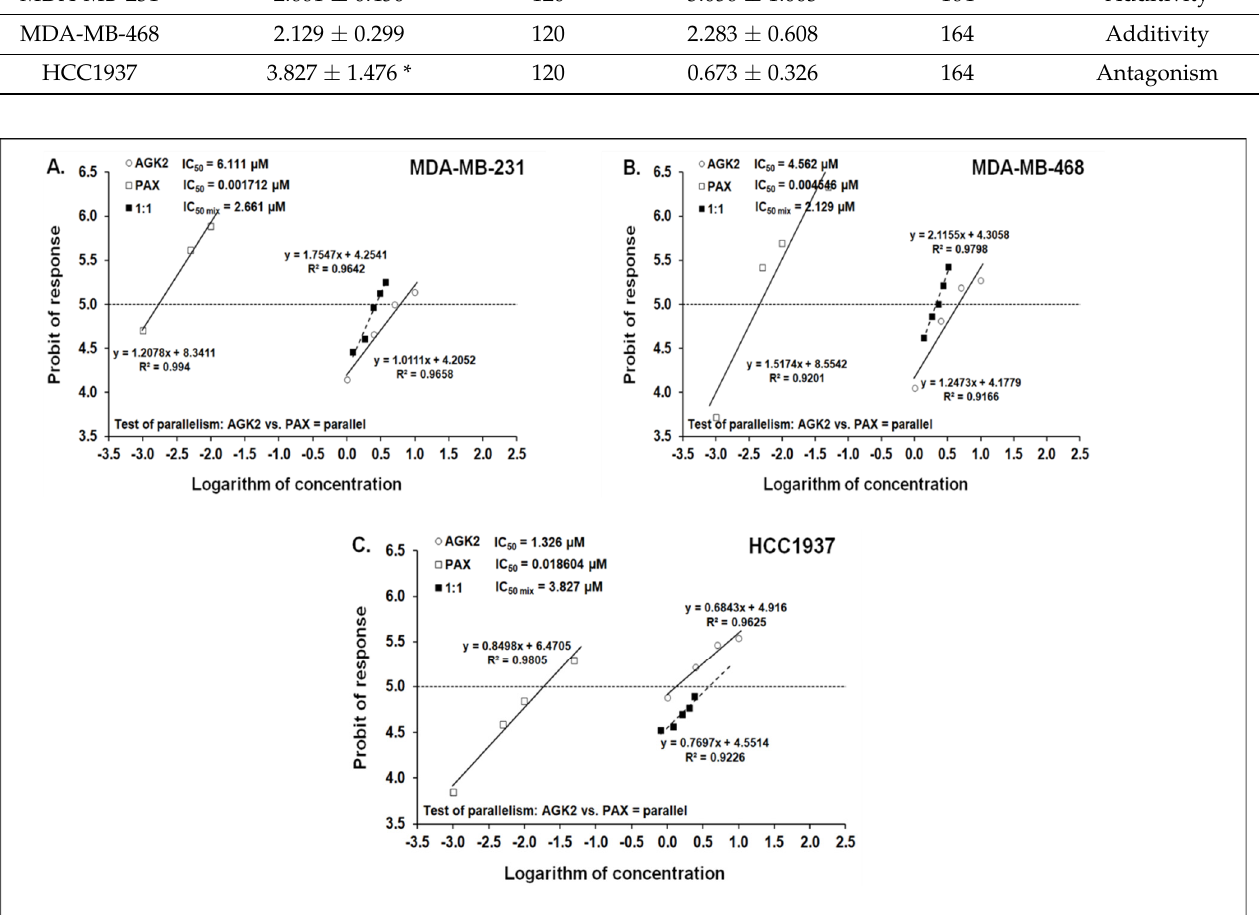
Figure 12. Log-probit concentration–effect relationship curves (CECs) for PAX and AGK2 in the MDA-MB-231 ( A ), MDA-MB-468 ( B ) and HCC1937 ( C ) cells measured using the MTT assay. Concentrations of PAX and AGK2 were administered separately, and the mixture of the drugs (1:1) was transformed into logarithms, whereas the antiproliferative effects produced by the drugs were transformed into probits [58]. Linear regression equations of CECs are presented on the graph where y is the probit of the response, x is the logarithm (to the base 10) of a drug concentration, R2—coefficient of determination. The dotted line indicates the approximate IC 50 values for the studied drugs given alone and the mixture of PAX and AGK2 in a constant ratio of 1:1. Test of parallelism of CECs for PAX and AGK2 indicated that both lines are mutually